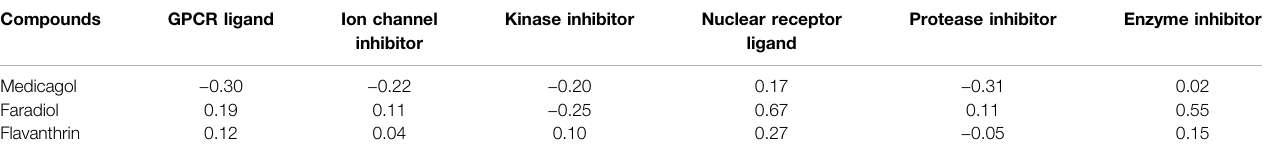
TABLE 3 | Biological activities of the screened hit phytochemicals were calculated from the Molinospiration chemoinformatics software package. Here Bioactivity score > 0 (biologically active); − 5.0 < Bioactivity score < 0 (moderately active); Bioactivity score < 0 (biologically inactive).